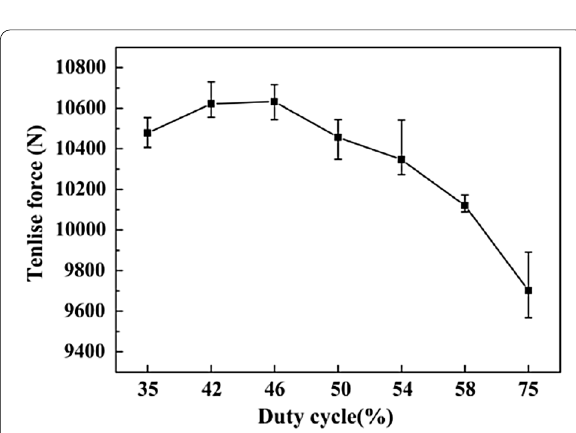
Figure 27 Tensile shear force of welded joints under different duty cycles